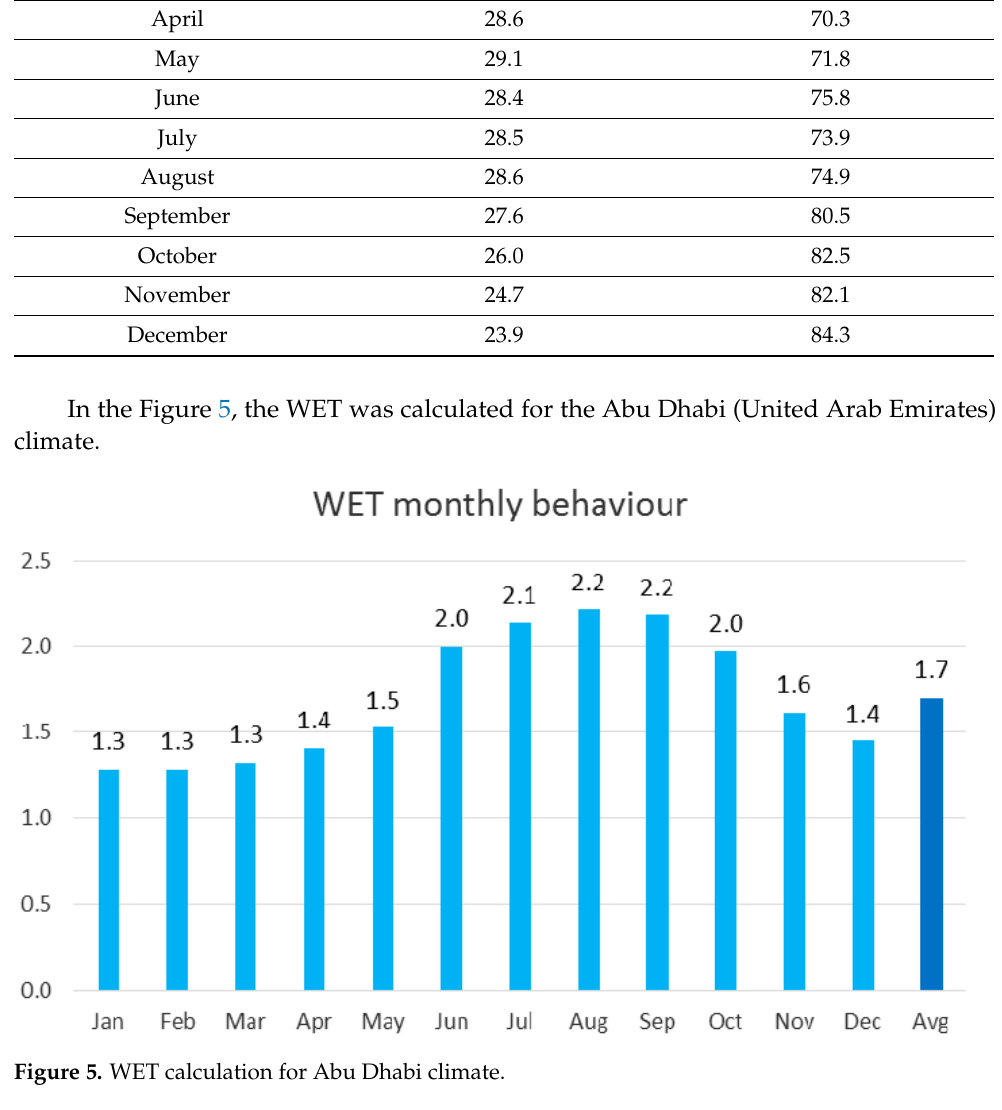
Table 10. Average weather data in Abu Dhabi.